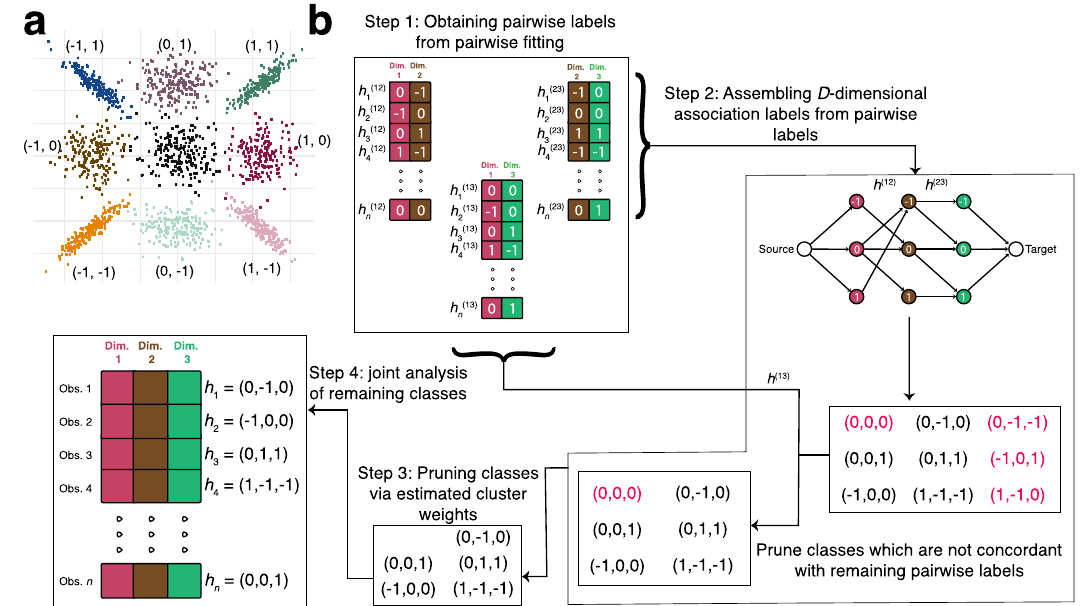
Fig. 1 | Toy example of CLIMB. a Illustration of the considered model using a simulated dataset with two dimensions. The 9 classes are annotated by their cor- respondinglatentassociationvectors.Thenullclass(0,0)liesinthecenteroverthe origin. Classes that are non-null in at least one dimension exhibit a location shift. Onlyobservationsfromclassesthatarenon-nullinbothdimensionsarecorrelated. b Flowchart of CLIMB with a 3-dimensional example, with true classes whose association vectors are denoted h 1 , h 2 , h 3 , h 4 ,and h n . Step 1 fi ts 3 pairwise models. Pairwiseassociationvectorsareestimatedforeachobservationineachpairwise fi t. InStep2,weenumeratecandidate3-dimensionalassociationvectorsusingagraph-